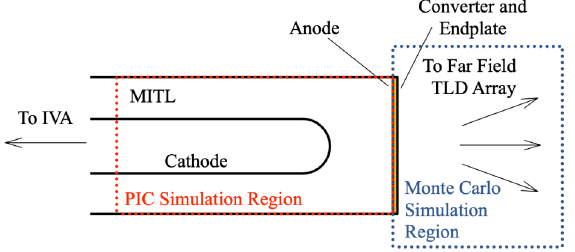
FIG. 1. Diagram showing the locations of the PIC and MC simulation regions, in relation to the geometry of the